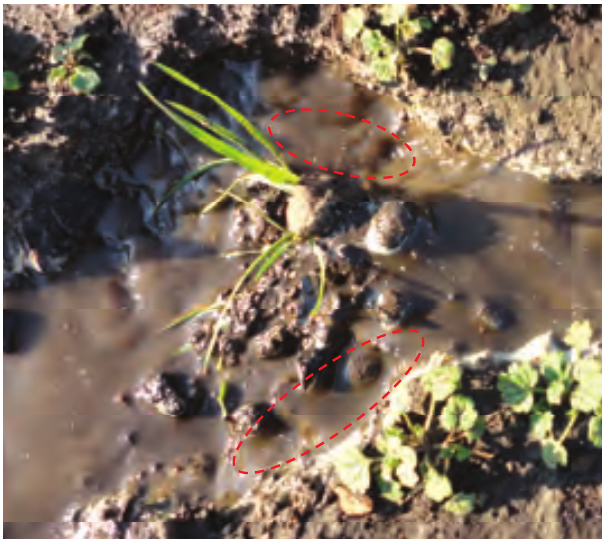
Fig. 7. Beads of larger diameters diffuse in the channel due to the presence of sediments and subrills, see red dashed ellipses. Fig. 5. Beads of smaller diameters trapped at the outside bend of the rill, see red dashed ellipse.